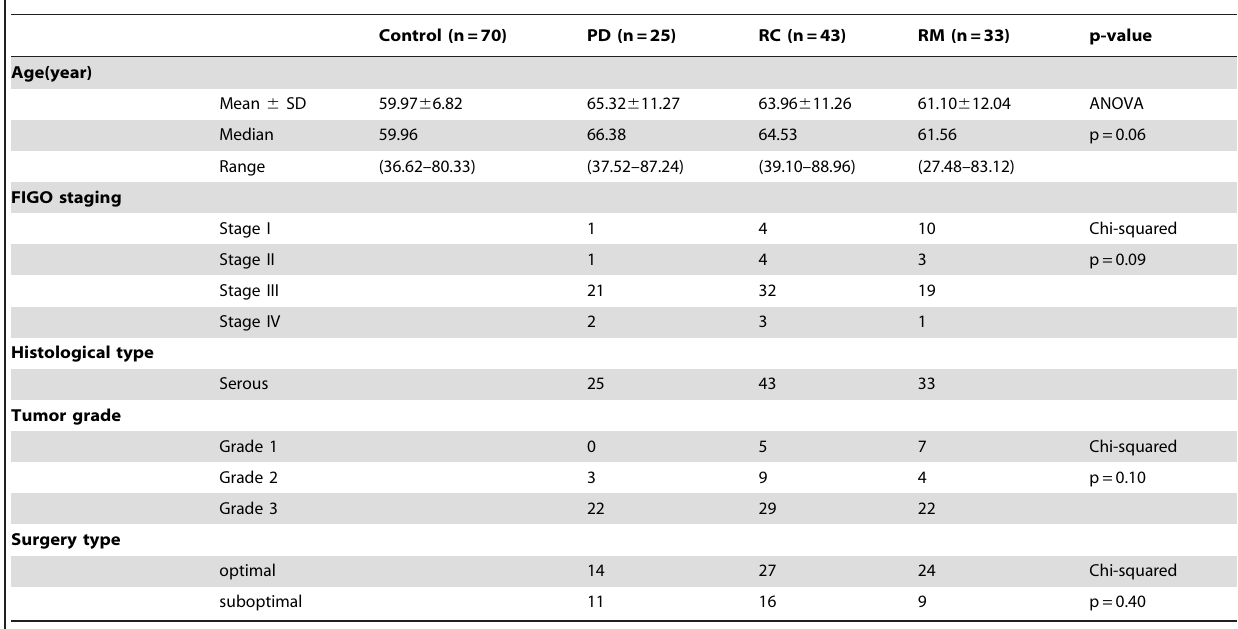
Table 1. Characteristics of the patient